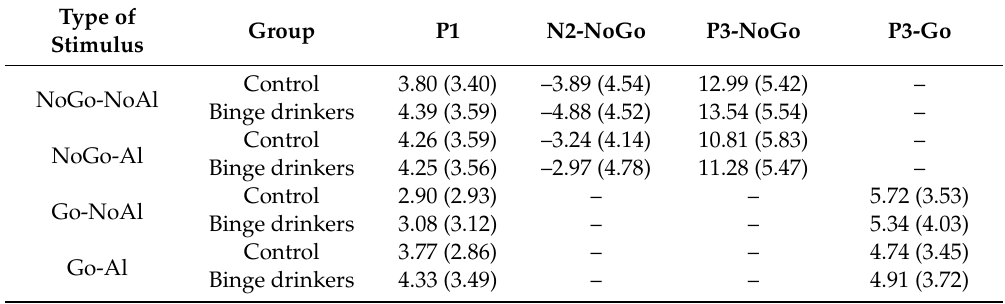
Table 4. Mean (SD) amplitude ( µ V) of each ERP component for di ff erent groups (control and binge drinkers) and type of stimulus (alcohol vs. nonalcohol; Go vs. NoGo).